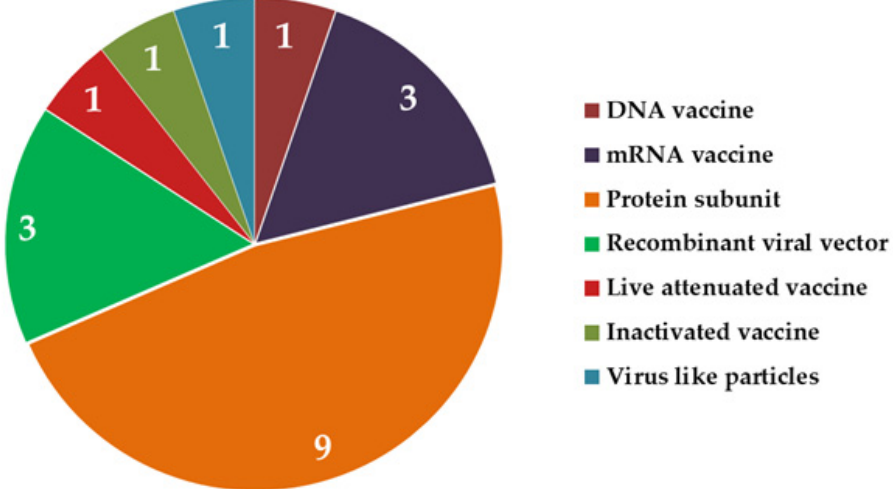
Figure 3. Vaccines currently in the final phase of clinical trial. Protein subunit vaccines (9) dominate the list followed by mRNA vaccine and recombinant viral vector (3 each). Each of live attenuated, inactivated, virus like particles, and DNA vaccines are in the final phase trial.